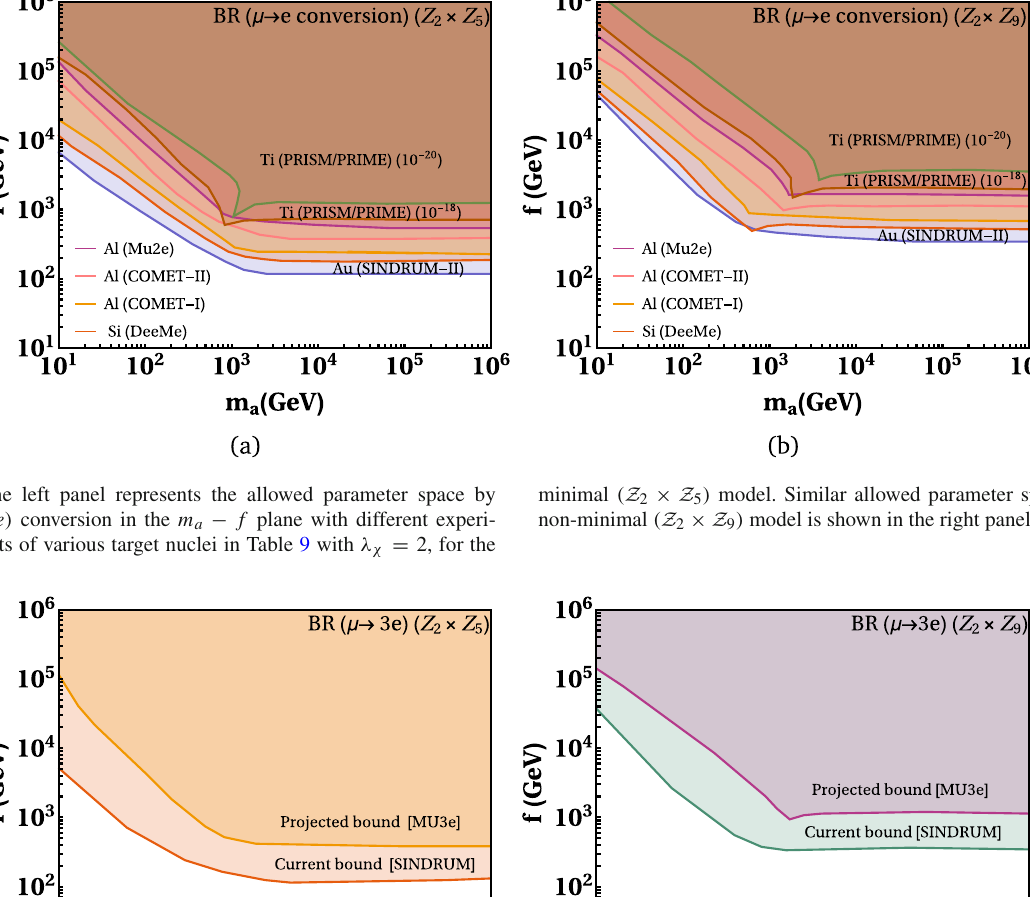
Fig. 14 The allowed parameter space by BR (μ → 3 e ) for the minimal ( Z 2 × Z 5 ) model on the left and for the non-minimal ( Z 2 × Z 9 ) model on the right with λ χ =